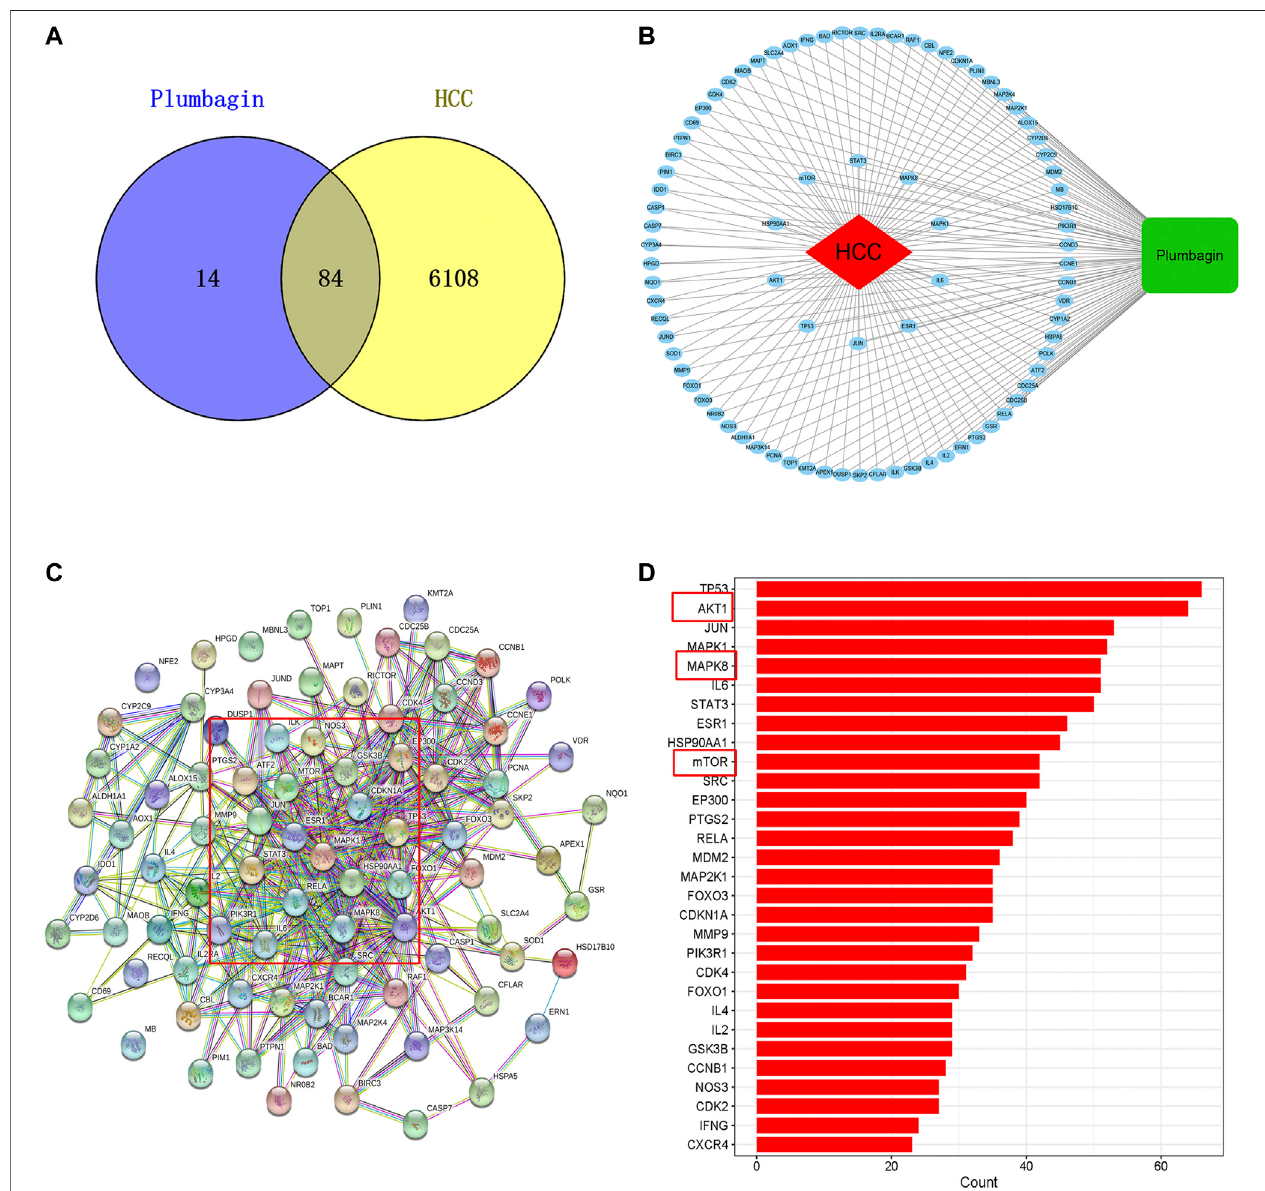
FIGURE 2 | (A) Venn diagram of common targets of plumbagin (PL) in HCC. (B) Network of PL targets and HCC targets. The rectangle represents the compound PL,theellipserepresents84commontargets,andthediamondrepresentsHCC.Theprotein-proteininteraction(PPI)networkbasedontargetsofPLinHCC. (C) Nodes represent different proteins. Edges represent protein-protein associations, and the line thickness indicates the strength of data support. (D) Bar plot of the protein- protein interaction (PPI) network. The X-axis represents the number of neighboring proteins of the target protein. The Y-axis represents the target proteins.